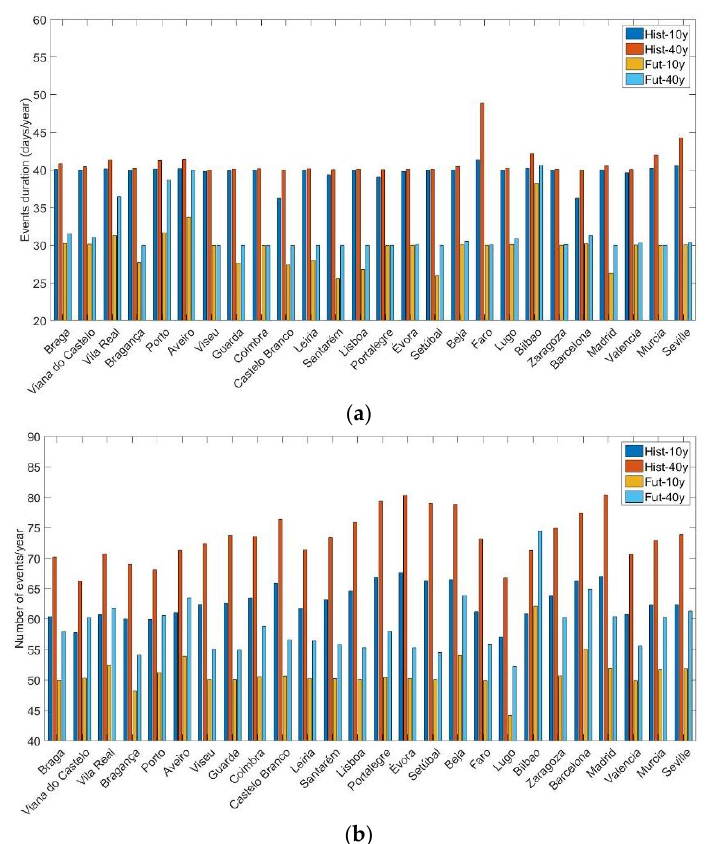
Figure 23. Comparison of the ( a ) event duration (days/year) and ( b ) the number of events (year) in the historical (blue) and future (red) period for extreme events with a return period of 10 years (full line) and 40 years (dashed line) for wind speed at 850 hPa.